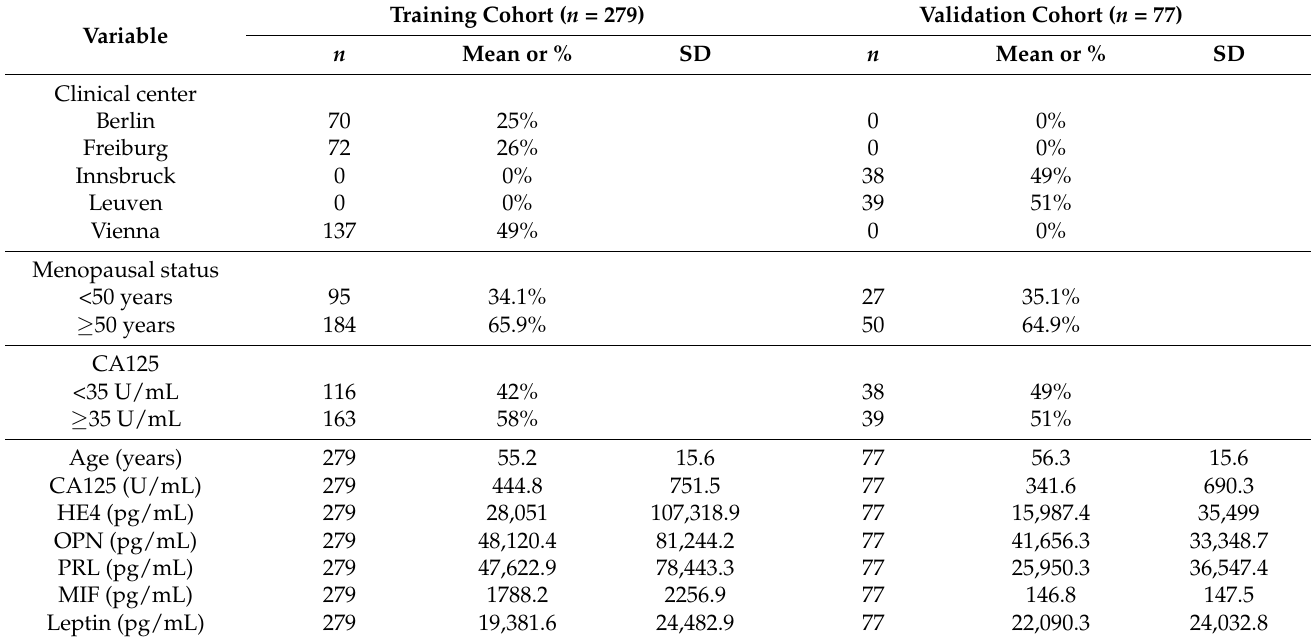
Table 1. Characteristics of the training and validation